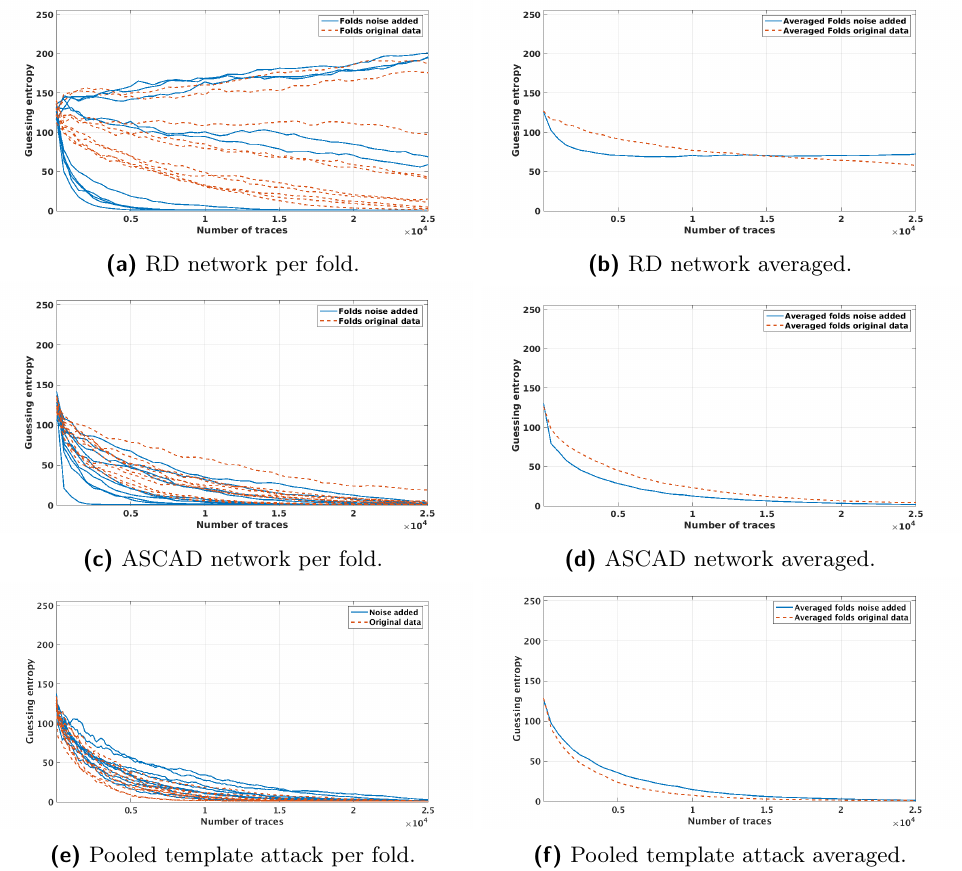
Figure 4: Guessing entropy results for the AES_HD